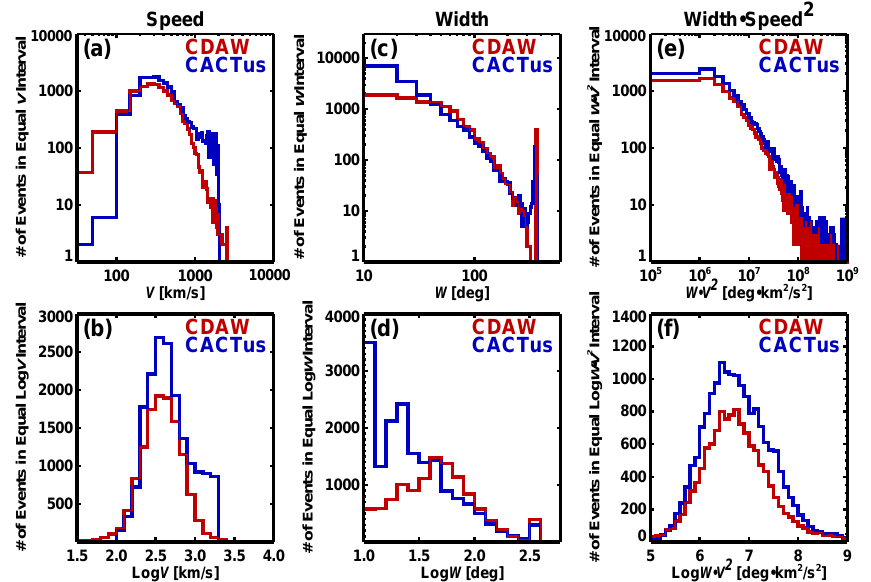
Fig. 2. Distributions of Speed ( V ; left), width ( W ; center), and W × V 2 (right) of CDAW (red) and CACTus (blue) CMEs. The parameter W × V 2 is used as a proxy of the kinetic energy. The number of events in each bin is counted by equal intervals on a linear scale (top) and on a log scale (bottom), which is usually used to investigate the power-law and log-normal distributions,